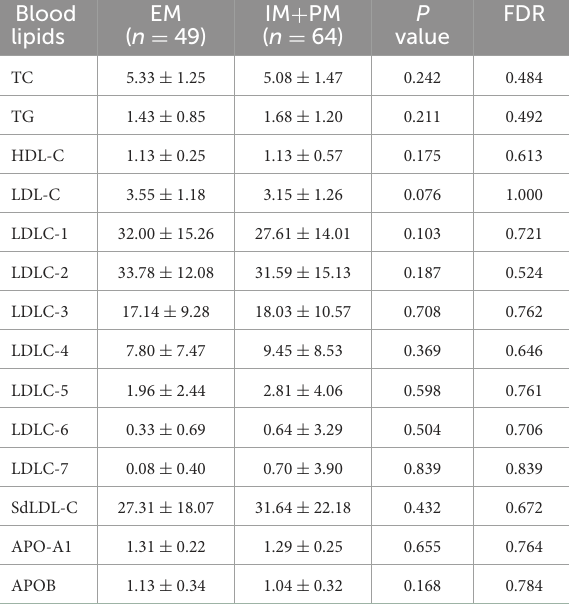
TABLE 6 Comparison of CAD patients’ blood lipids according to CYP2C19 metabolizer status. Blood